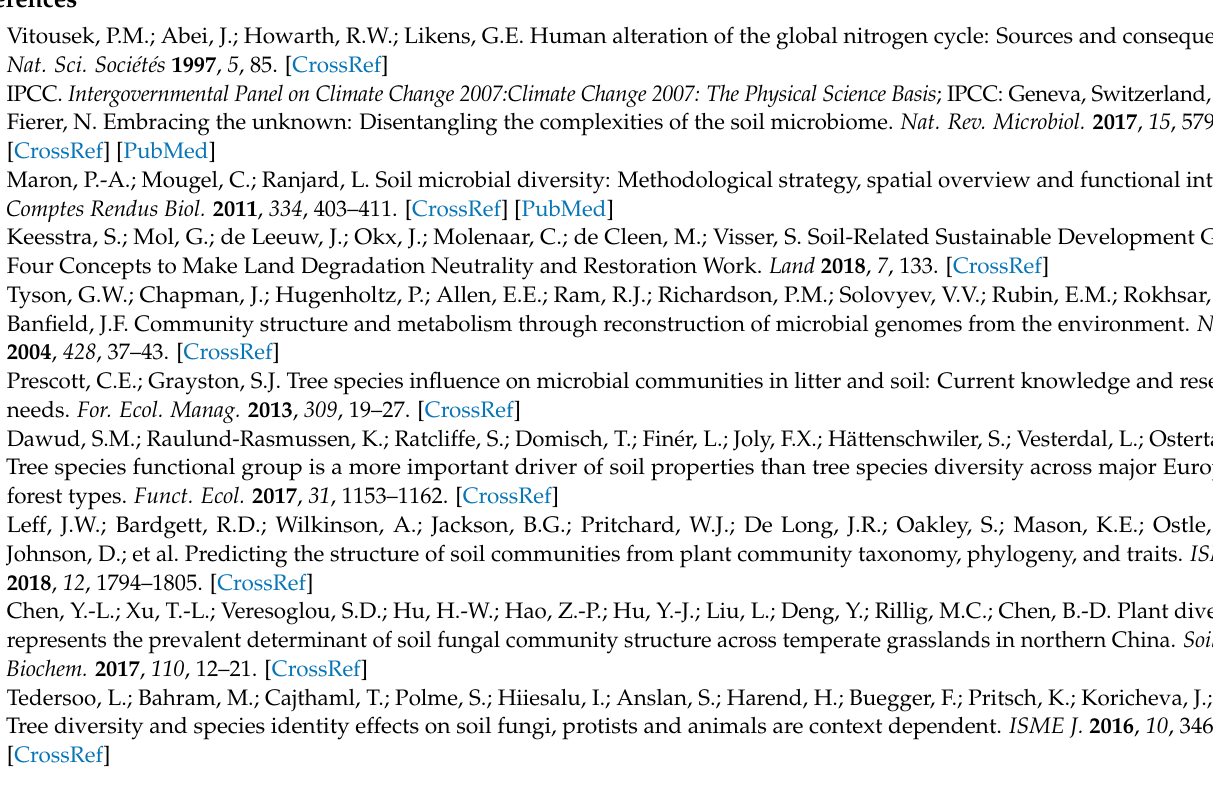
Table S2: ANOSIM analysis results, based on the rank of the distance between monoculture groups and all groups. Table S3: Number of nodes and edges in bacterial-fungal co-occurrence network. +, represents positive correlation; -, represents negative correlation, Figure S1: The abundance of fungi functional identified based on FunGuild